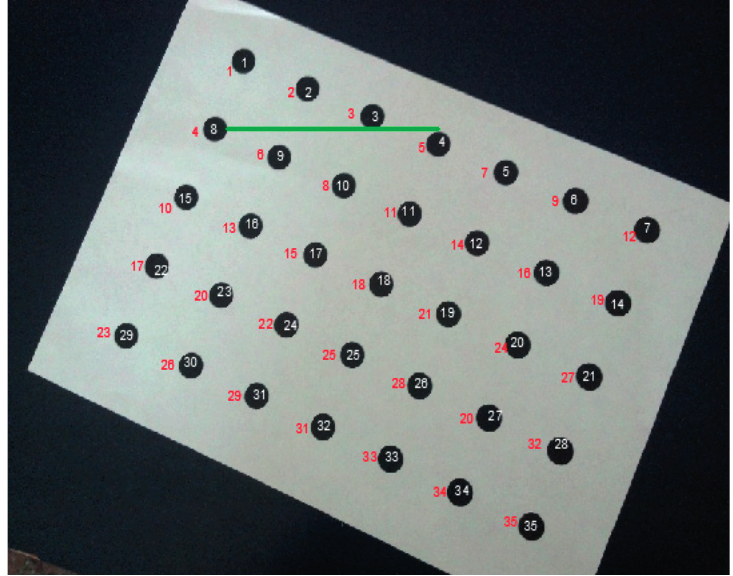
Figure 7. High inclination of a camera’s principal axis giving wrong sorting and numbering of control points (red colored points’ codes). The point with No. 8 (code in white color inside the circle) is erroneously getting the code No. 4 (red colored code) just because its j coordinate on the image (distance from first image row) is smaller than the j coordinate of all the other points below the green